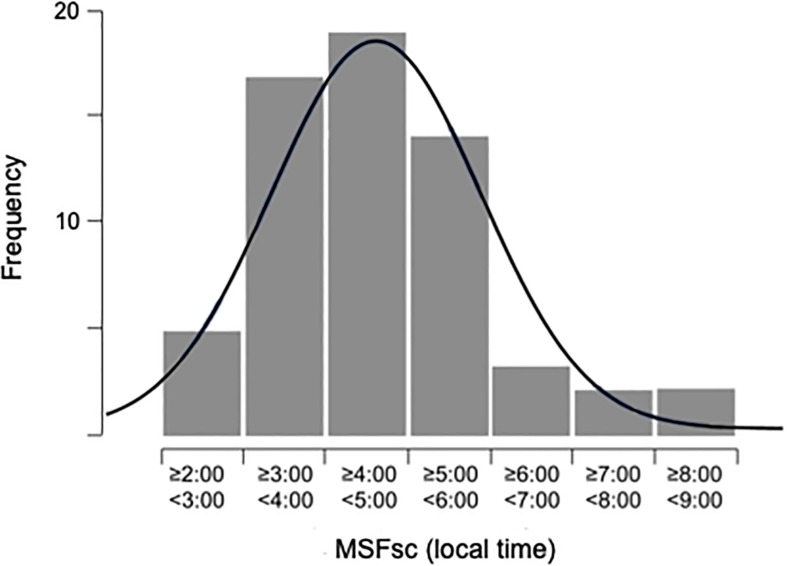
Distribution of chronotype (MSFsc; sleep-corrected mid-sleep on free days; local time). Sample size = 62, average age 40.45 ± 14.89 years, ranging from 18 to 65 years.